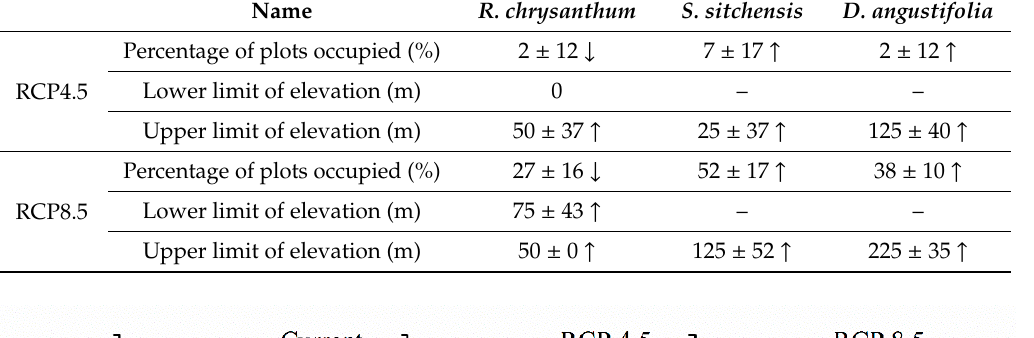
Table 3. Potential changes in dominant Changbai Mountains tundra plant species by 2045 under two RCP scenarios.